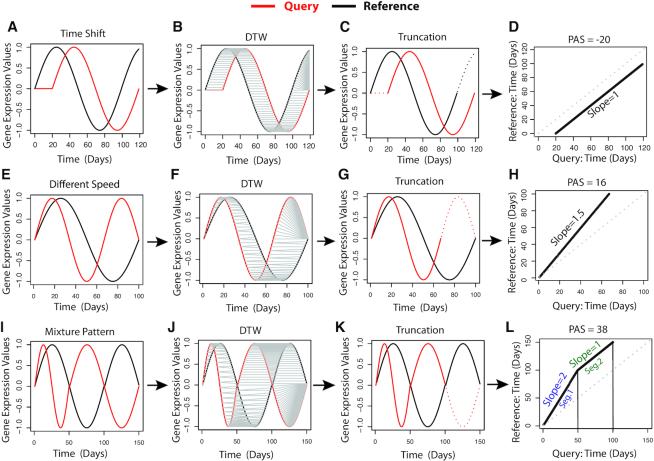
Illustration of TimeMeter by simulated high density discrete data. (A–D) Time shift pattern. (E–H) Different speed of dynamical change pattern. (I–L) Mixed pattern: the query has a 2-fold faster in dynamical change compared to the reference for the first 50 days, but after the first 50 days, the query has the same speed of dynamical change with the reference. TimeMeter uses DTW to align gene expression values, and then prunes excessively duplicated start or end points aligned indices, and truncates corresponding time points (C, G and K; dashed lines). TimeMeter applies piecewise (segmented) regression to aligned time points (after truncation), and partitions them into separate segments if more than one pattern is detected, such as figure (I). A progression advance score (PAS) is calculated by aggregation of area difference in each segment and normalized by total aligned time length (after truncation) in query.